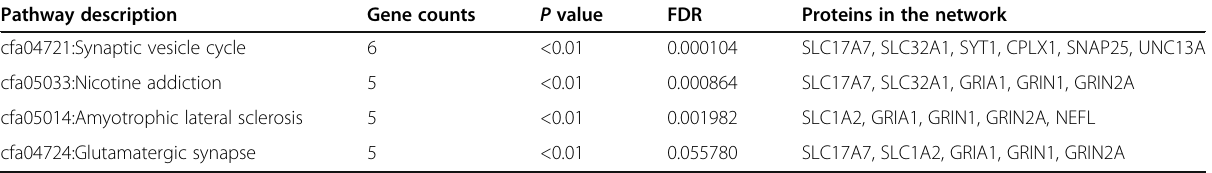
Table 2 KEGG pathway enrichment analyses of DEGs in the most significant module Pathway description Gene counts Proteins in the